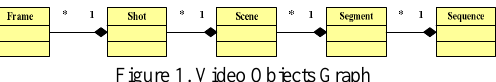
Figure 1. Video Objects